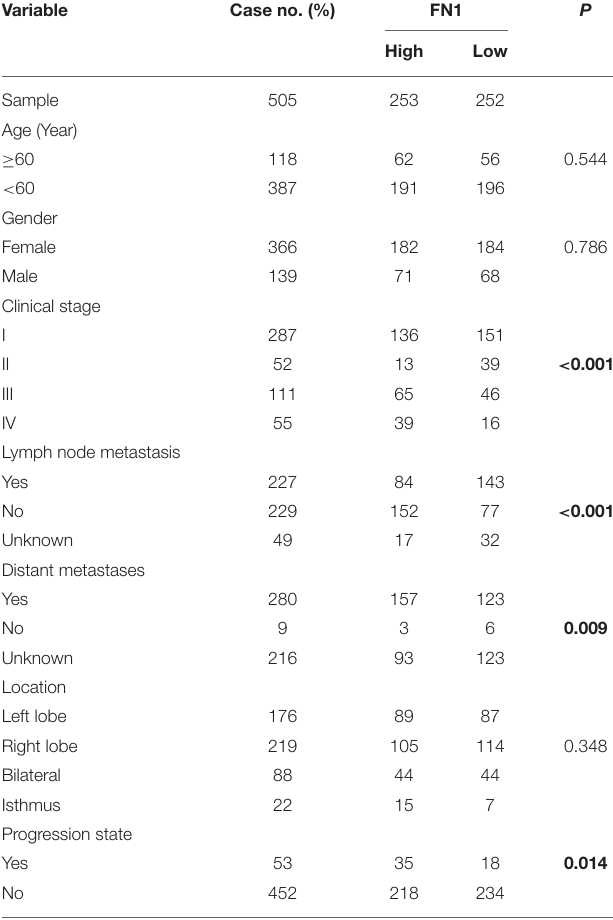
TABLE 3 | Comparison of clinical characteristics between low FN1 group and high FN1 group in THCA cohort.